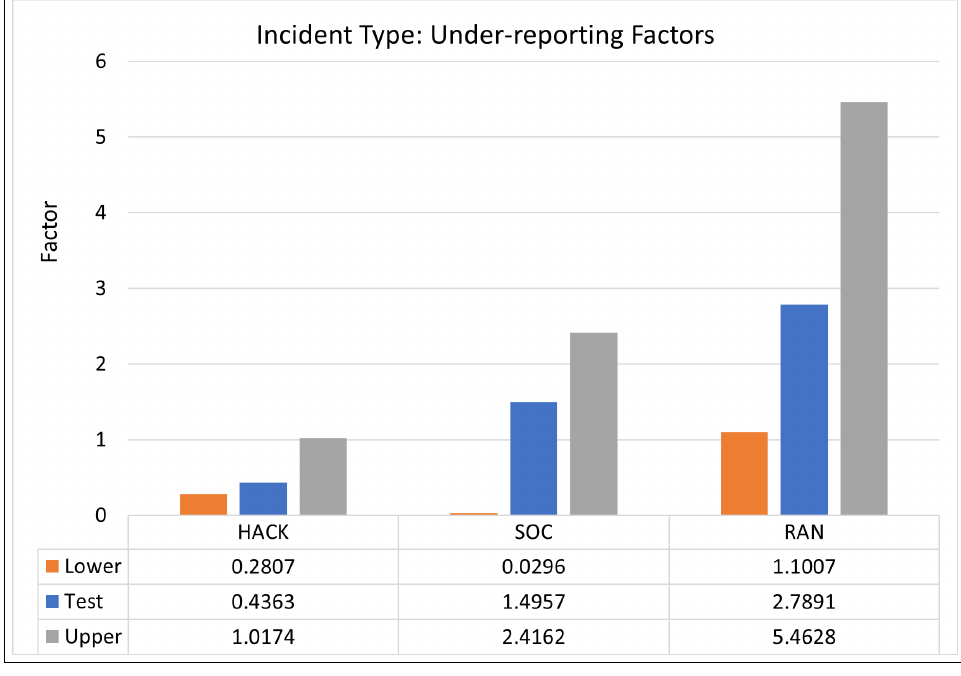
Figure 6. Under-reporting Factors: Incident Type.